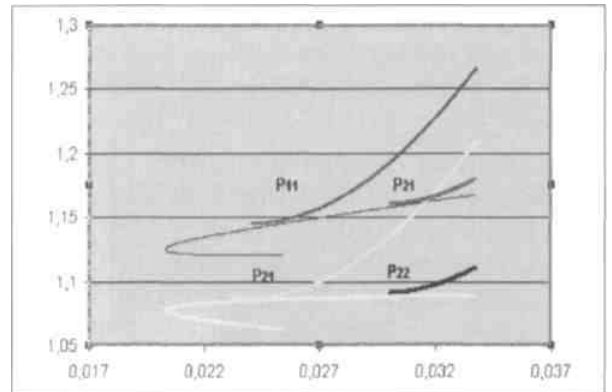
Fig 6. The map of interaction between two currencies portfolio possibilities and investor utilities is shown value), the size of accumulated sum (ordinate value), reliability value (reliability level of effective line), usefulness of portfolio (calculated using use function), portfolio structure (w,